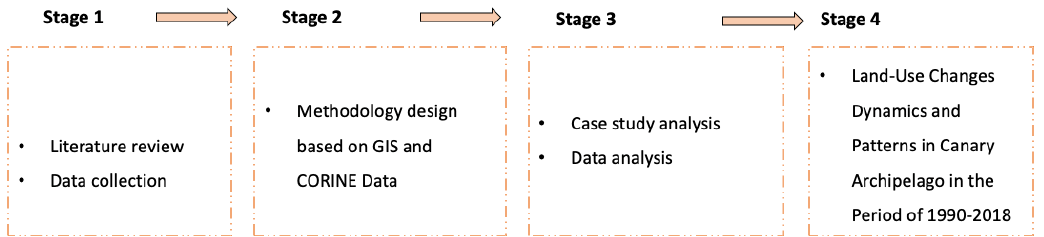
Figure 1. Methodology scheme.